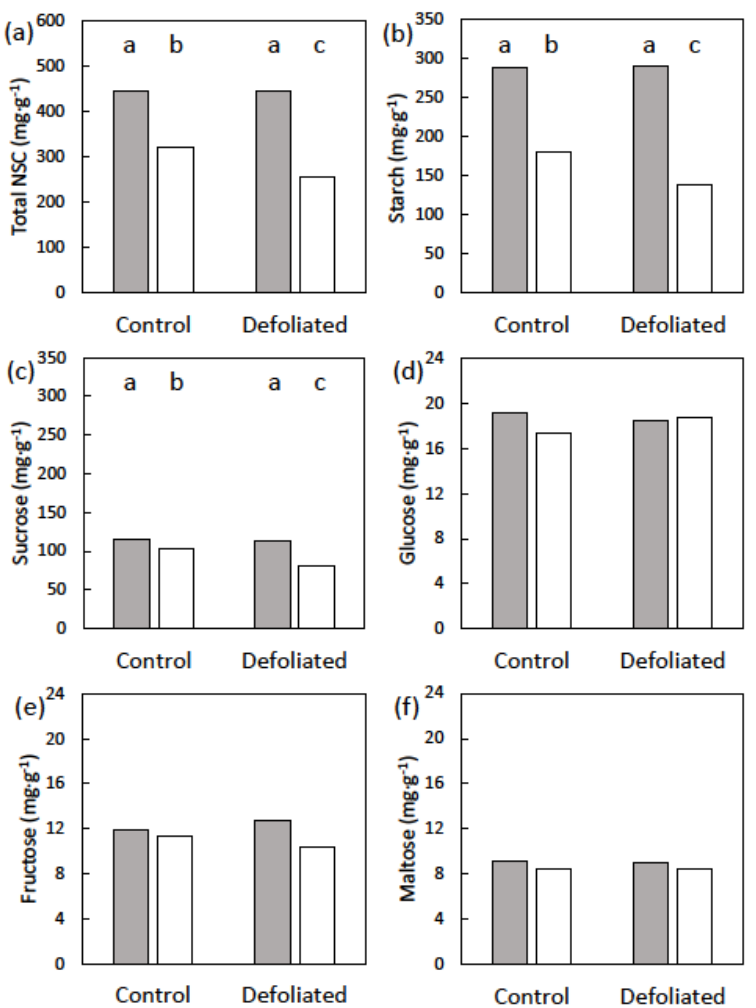
Figure 2. The non-structural carbohydrates (NSC) of Cycas micronesica stem tissues before (gray bars) and after (white bars) the construction of male cones, as influenced by defoliation prior to cone growth. ( a ) Total NSC; ( b ) starch; ( c ) sucrose ( d ) glucose; ( e ) fructose; and ( f ) maltose. Bars with same letters are not different for NSCs with significant time × treatment effects.